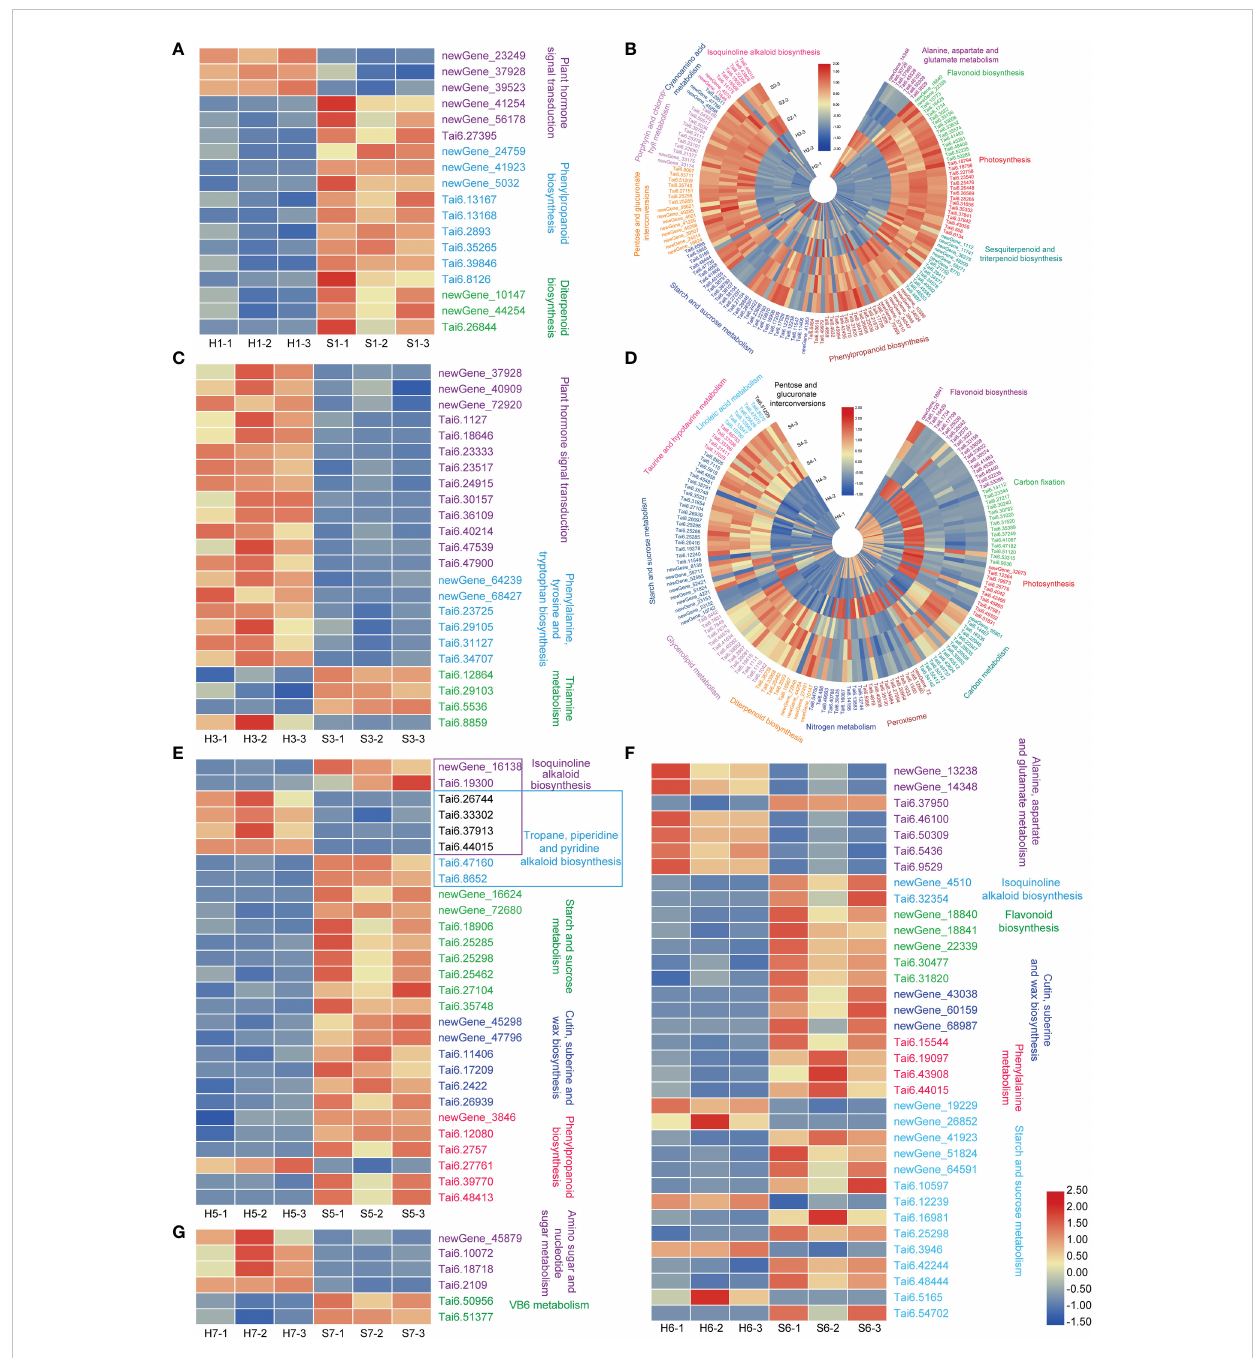
FIGURE 7 Heatmaps of the enriched KEGG pathways of DEGs in the different of sweet potato cultivars under the drought stress. (A) , drought-treated Shangshu-9/control Shangshu-9; (B) , drought-treated Chaoshu-1/control Chaoshu-1; (C) , drought-treated Xushu-22/control Xushu-22; (D) , drought-treated Z15-1/control Z15-1; (E) , drought-treated Xushu-18/control Xushu-18; (F) , drought-treated Jishu-26/control Jishu-26; (G) , drought-treated Xuzi-8/control